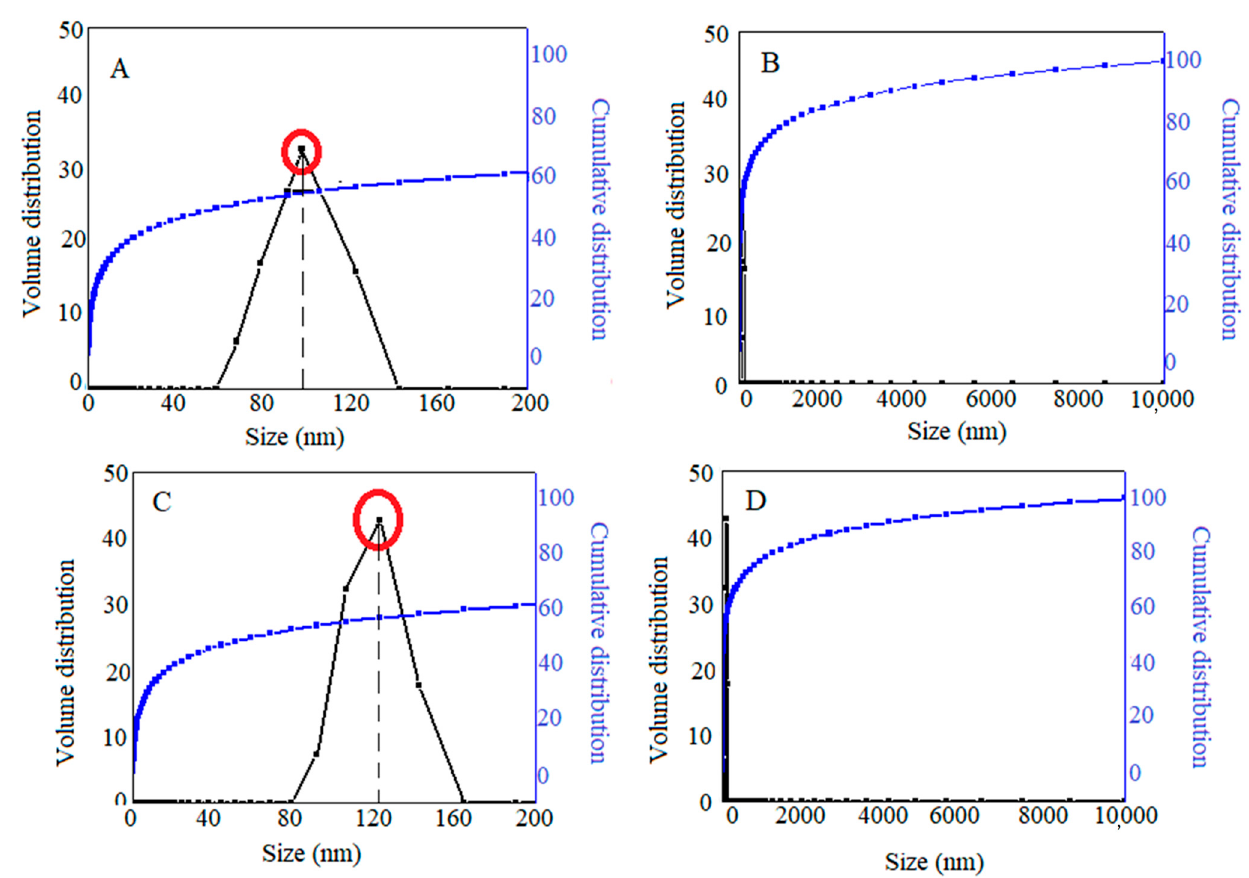
Figure 6. Particle size, relative of the ( A ) Fe 3 O 4 nanoparticles; and ( C ) Fe 3 O 4 @-PEG-SFB nanocomposite; and cumulative distributions of the ( B ) Fe 3 O 4 nanoparticles; and ( D ) Fe 3 O 4 @-PEG-SFB nanocomposite. Note: The red circle indicate the hydrodynamic size of nanoparticles expressed in the text.